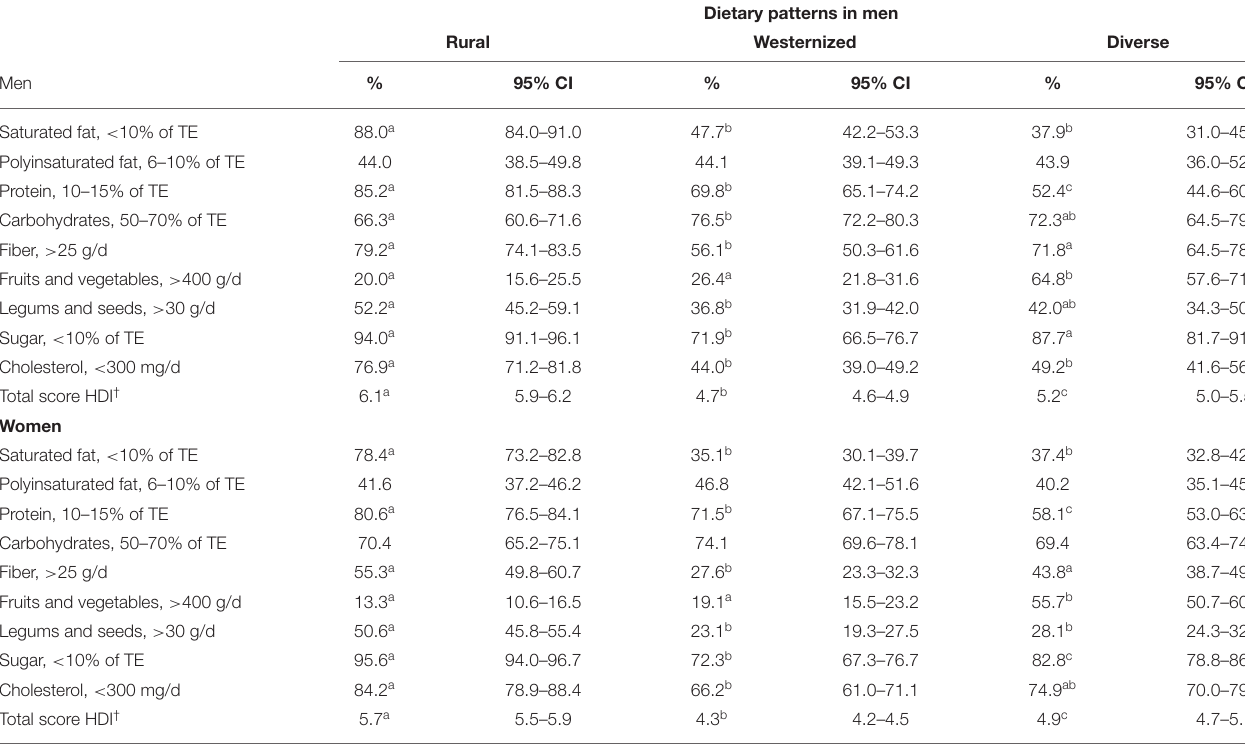
TABLE 4 | Adherence to the healthy diet indicator components and score by dietary pattern and gender, in Mexican adults. Dietary patterns in men Rural Westernized